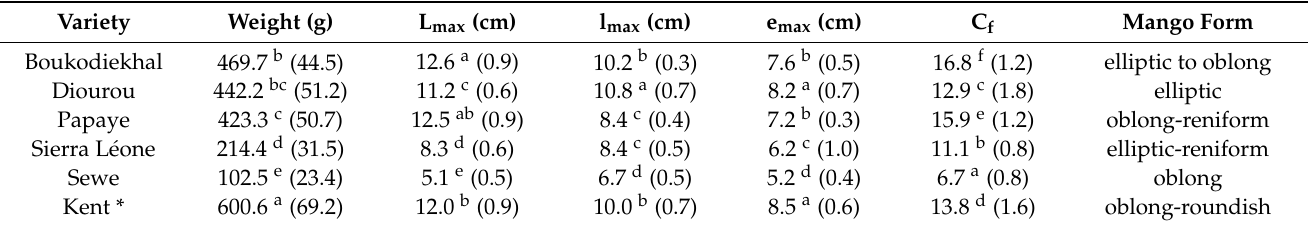
Table 1. Weight, dimension and form parameter (C f ) values of different mango